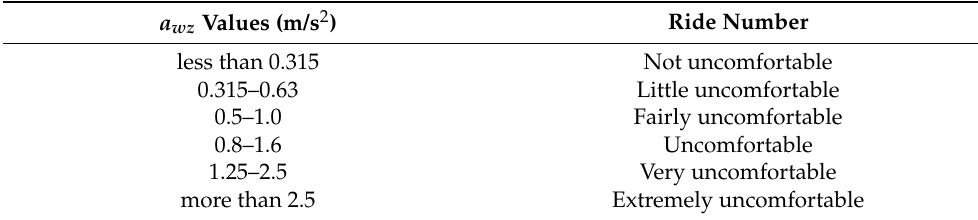
Table 3. Comfort levels related to a wz threshold values as proposed by ISO 2631 for public transport. a wz Values (m/s 2 ) Ride Number